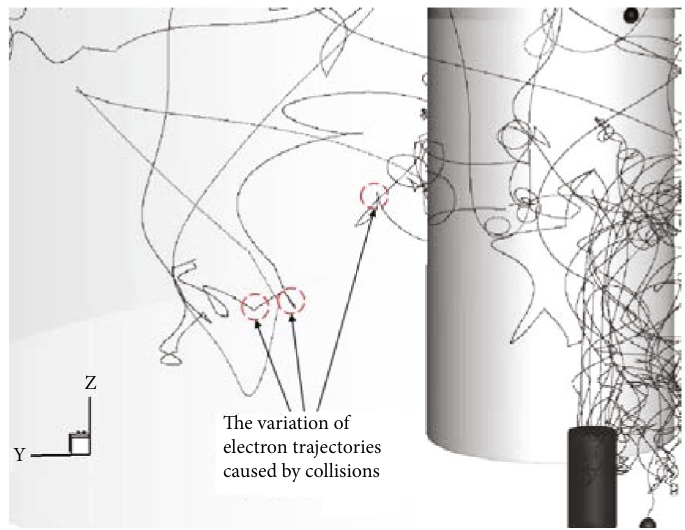
Figure 12: Primary electron trajectories near the anode